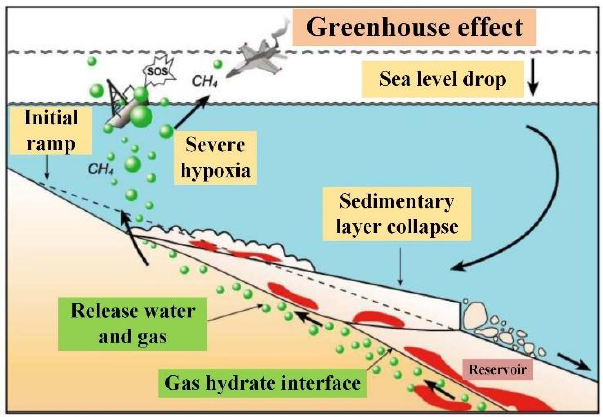
Figure 1. Decomposition of gas hydrates causes landslides [13].